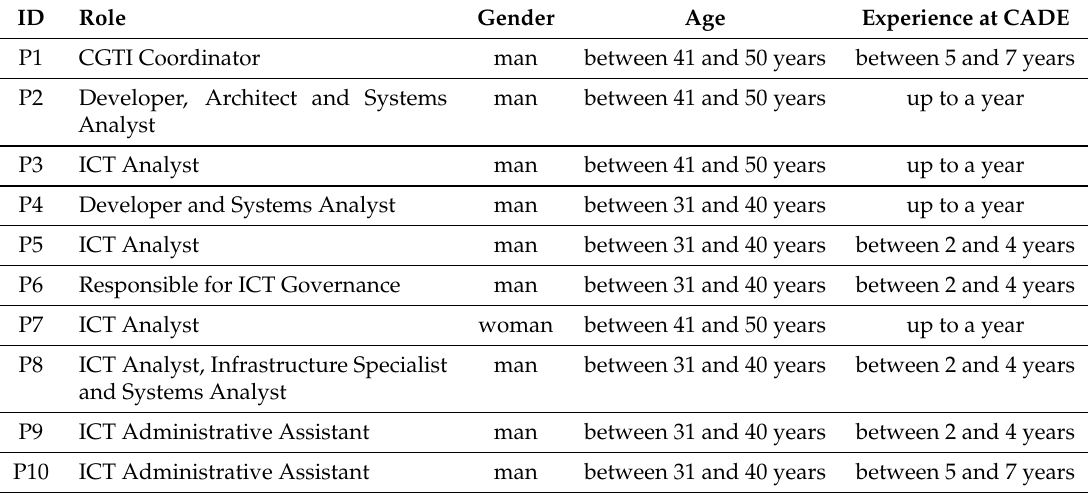
Table 1. Profile